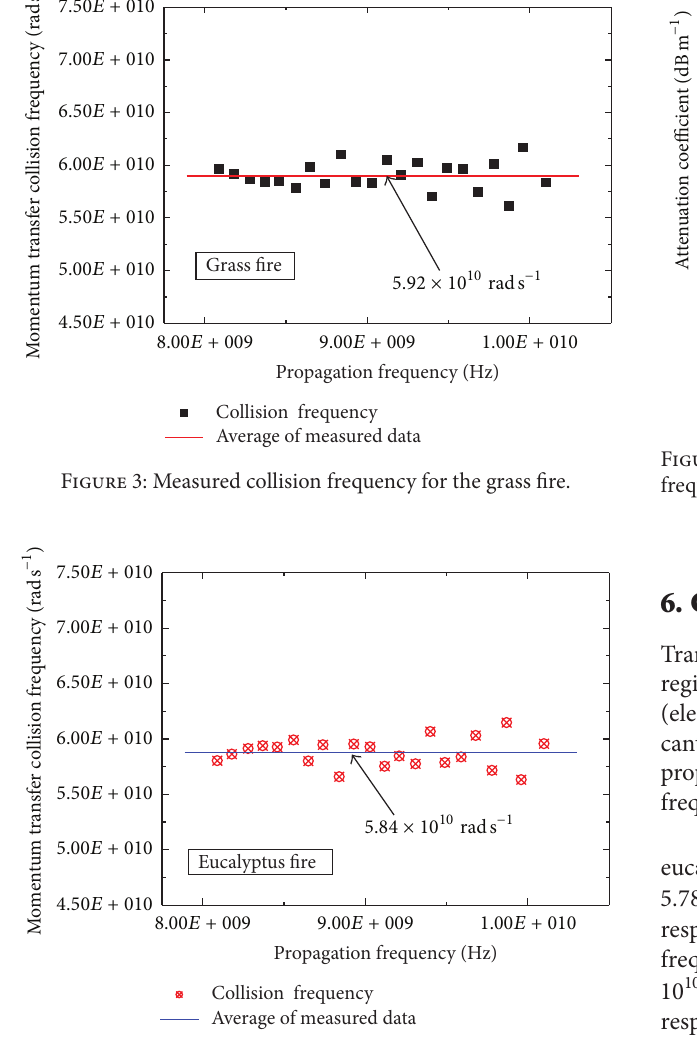
Figure 4: Measured collision frequency for eucalyptus fire.